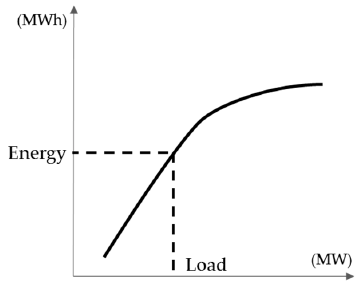
Figure 3. Illustrative load-energy curve.